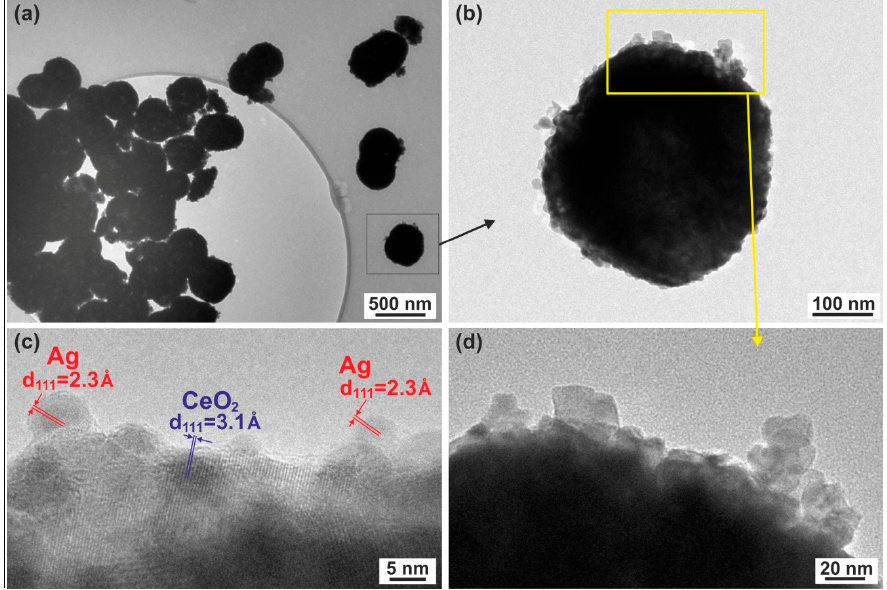
Figure 3. TEM ( a , b , d ) and HR-TEM ( c ) images of Ag–CeO 2 catalyst. Catalysts 2020 , 10 , x FOR PEER REVIEW